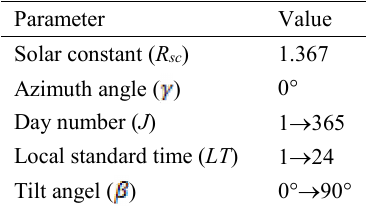
Table 2. Constant input data.